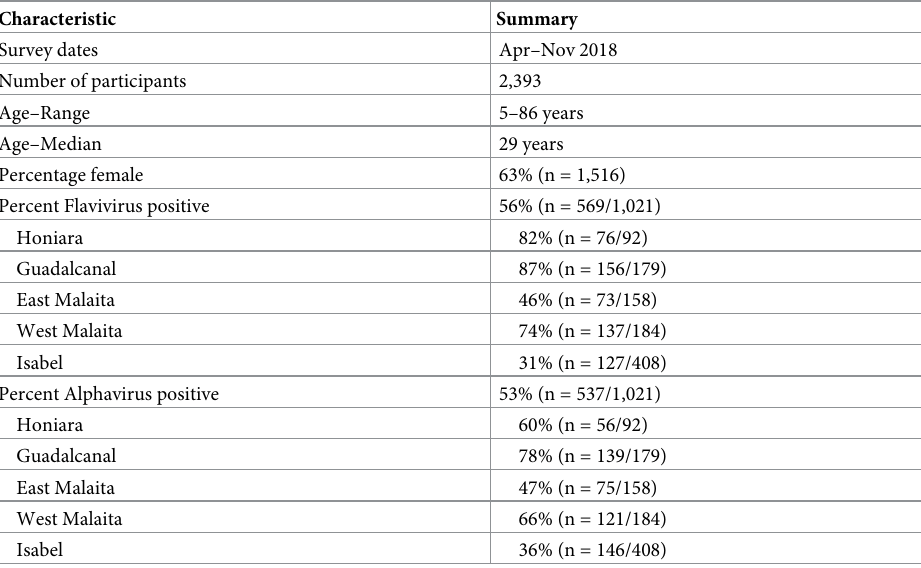
Table 1. Study population summary